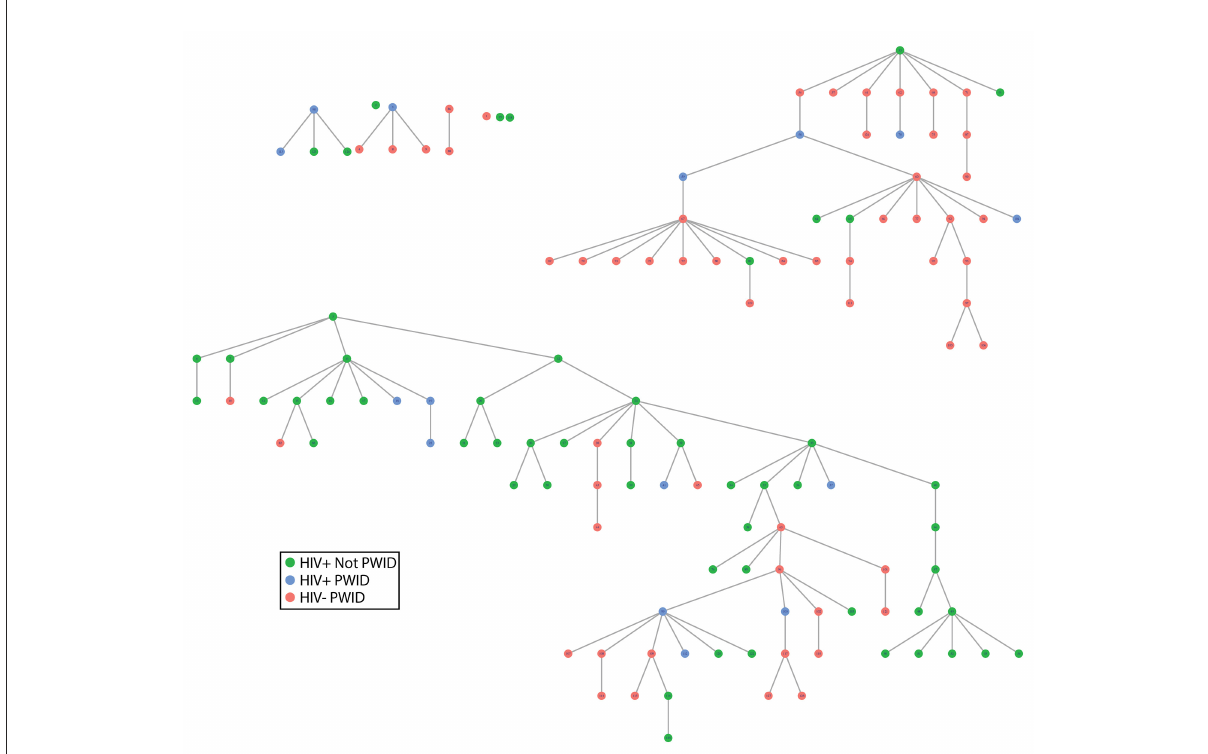
FIGURE1 RDS tree. Each node represents a participant where the roots of each tree are the seed participants, and the edges denote participants recruited by each seed. The colors indicate the HIV and injection status of the participants. Abbreviations: RDS, respondent-driven sampling; HIV, human immunodeficiency virus; PWID, people who inject drugs.